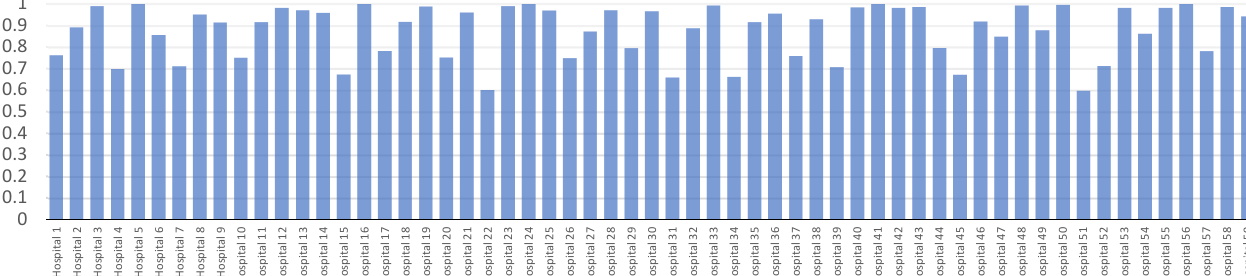
Figure 2. Hospitals’ technical efficiency results using BCC-CCR.